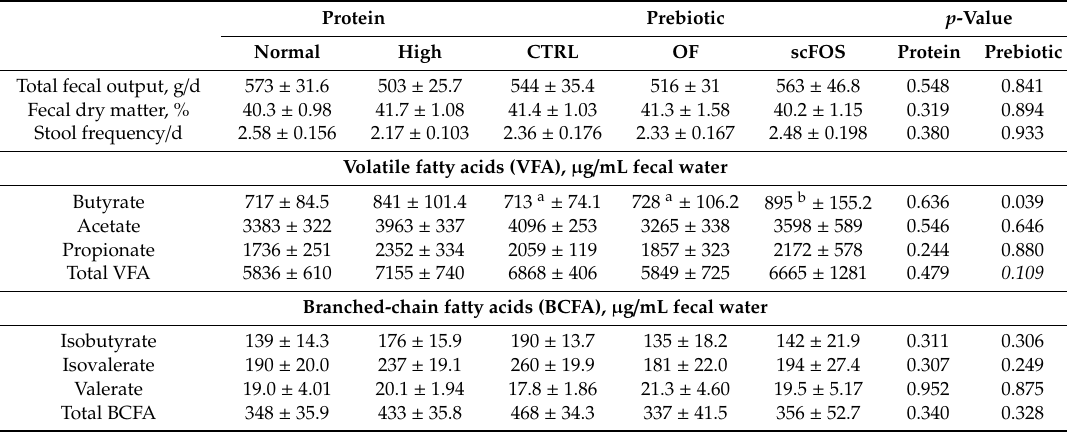
Table 3. Averaged e ff ects of protein level and prebiotic supplementation on feces characteristics and fecal concentrations of fermentation end-products. Protein Prebiotic p -Value Normal High CTRL OF scFOS Protein Prebiotic